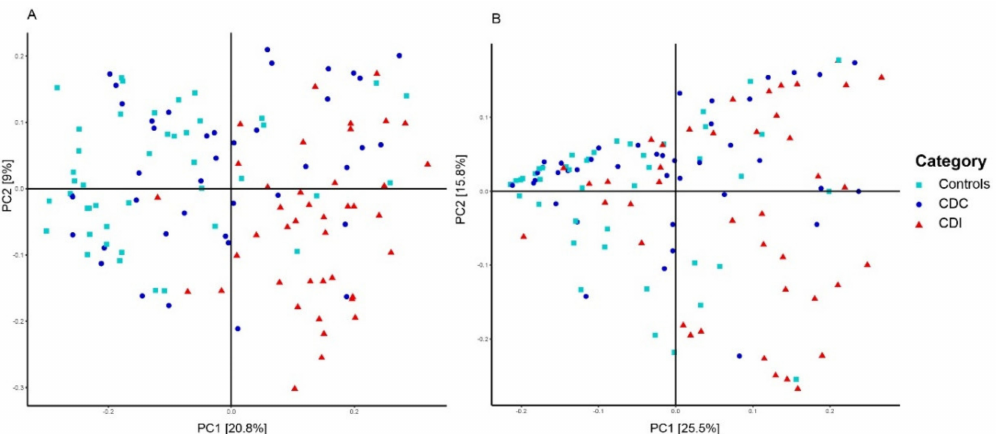
Figure 2. Principal Coordinates Analysis (PCoA) based on unweighted ( A ) and weighted ( B ) UniFrac distances. Each sample is represented by a shape and colur according to its category. The percentage of variation explained by the two first PCoA dimensions is indicated on the respective